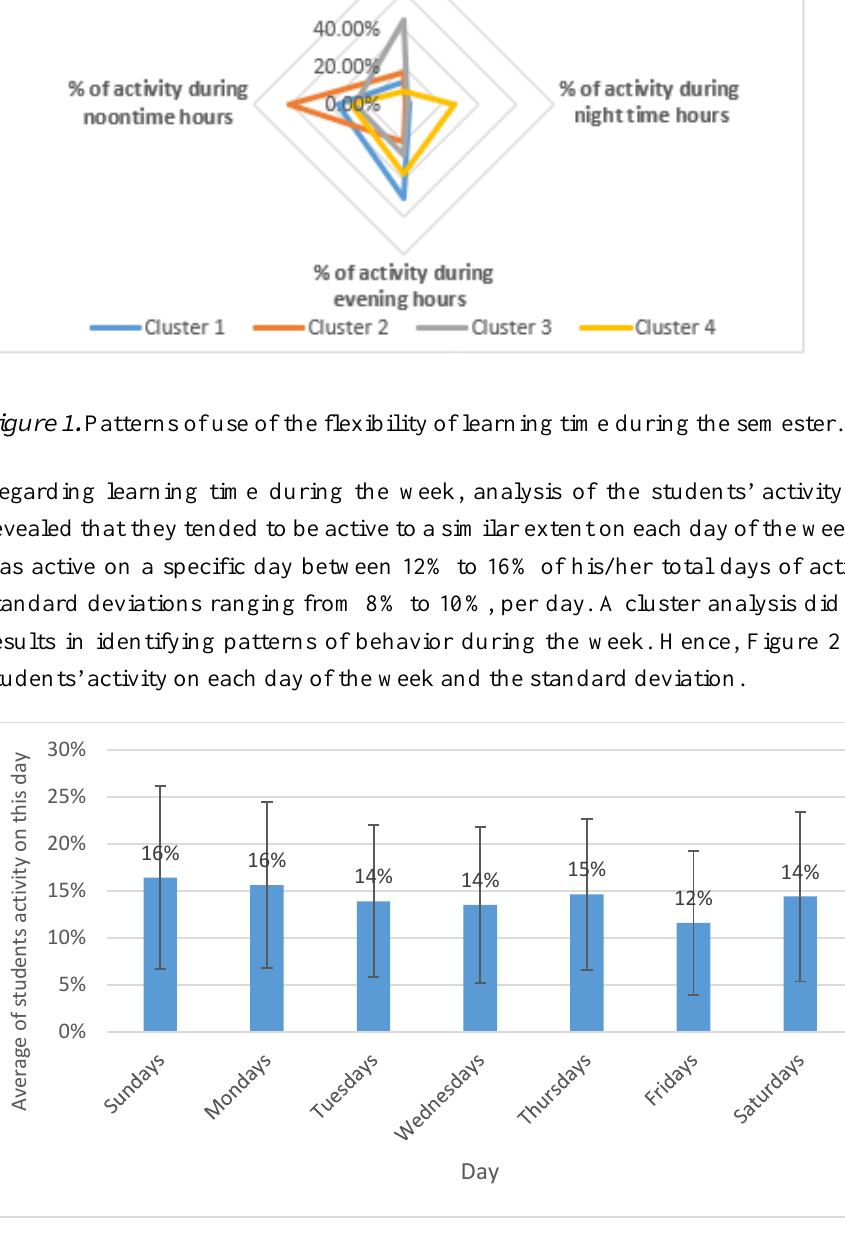
Figure 2 . Average of students’ activity on each day of the week and the standard